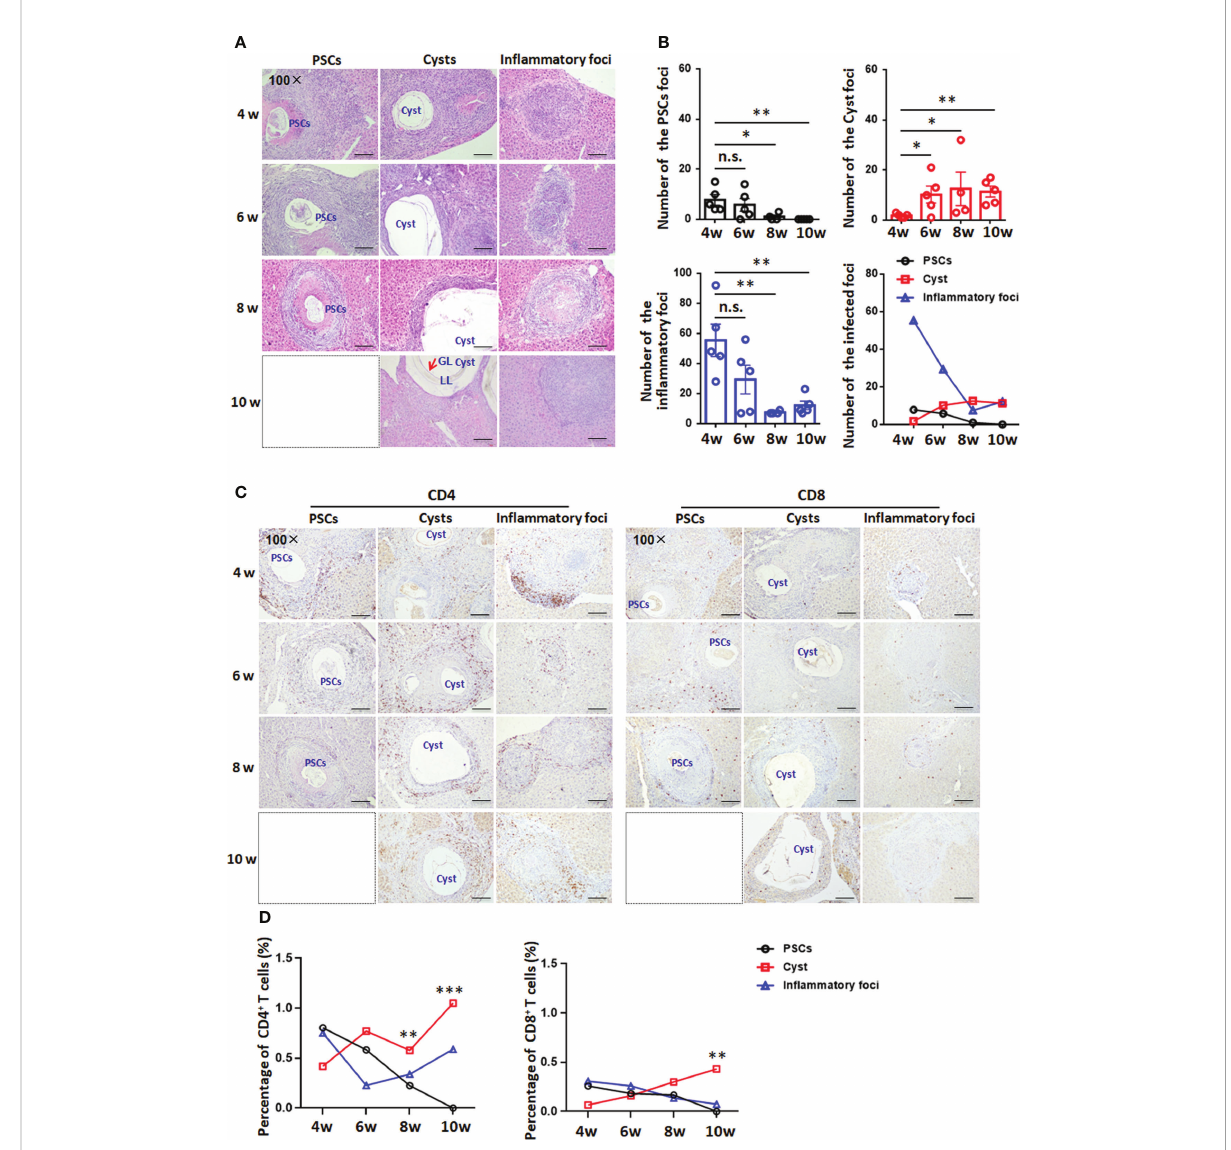
FIGURE 3 Histopathology and immunohistochemical analysis of CD4 + T cells and CD8 + T cells in the liver in a mouse model during Egranulosus s.s. establishment. (A) Histopathological alterations of the liver from mice model during Egranulosus s.s. establishment (protoscoleces develop into hydatid cysts). H&E staining of liver sections (original magni fi cation 100×). (B) Hepatic granulomatous response to Egranulosus infection establishment. Liver histological reaction at each infectious foci was scored as (1) PSCs foci, visible PSCs, only composed of in fi ltrating in fl ammatory cells and fi brosis; (2) infectious foci, cystic structure composed of the germinal layer and laminated layer, as well as fi brosis (adventitial layer, AL); (3) in fl ammatory foci, parasite-free, composed of macrophages, lymphocytes, and other in fl ammatory cells. (C) Representative images for CD4 and CD8 staining on liver sections (original magni fi cation 100×) from mouse model during Egranulosus s.s. establishment. (D) The percentage of in fi ltrating CD4 + T cells or CD8 + T cells on liver sections, from (C) . 4-5 mice per group. PSCs, protoscoleces; LL, laminated layer; GL, germinal layer; Cyst, hydatid csyst. The dotted box represents the absence of PSC-type lesions. Data are expressed as mean ± SD or mean, analyzed by Student ’ s t tests or one way ANOVA. * P < 0.05, ** P < 0.01, *** P < 0.001, no signi fi cance(n.s.) P >